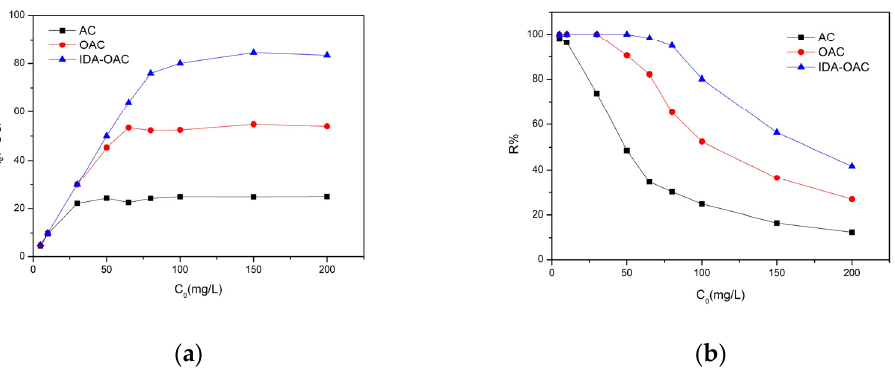
Figure 5. The adsorption capacity ( a ) and the removal efficiency ( b ) for AC, OAC, and IDA-OAC in the different initial concentrations.